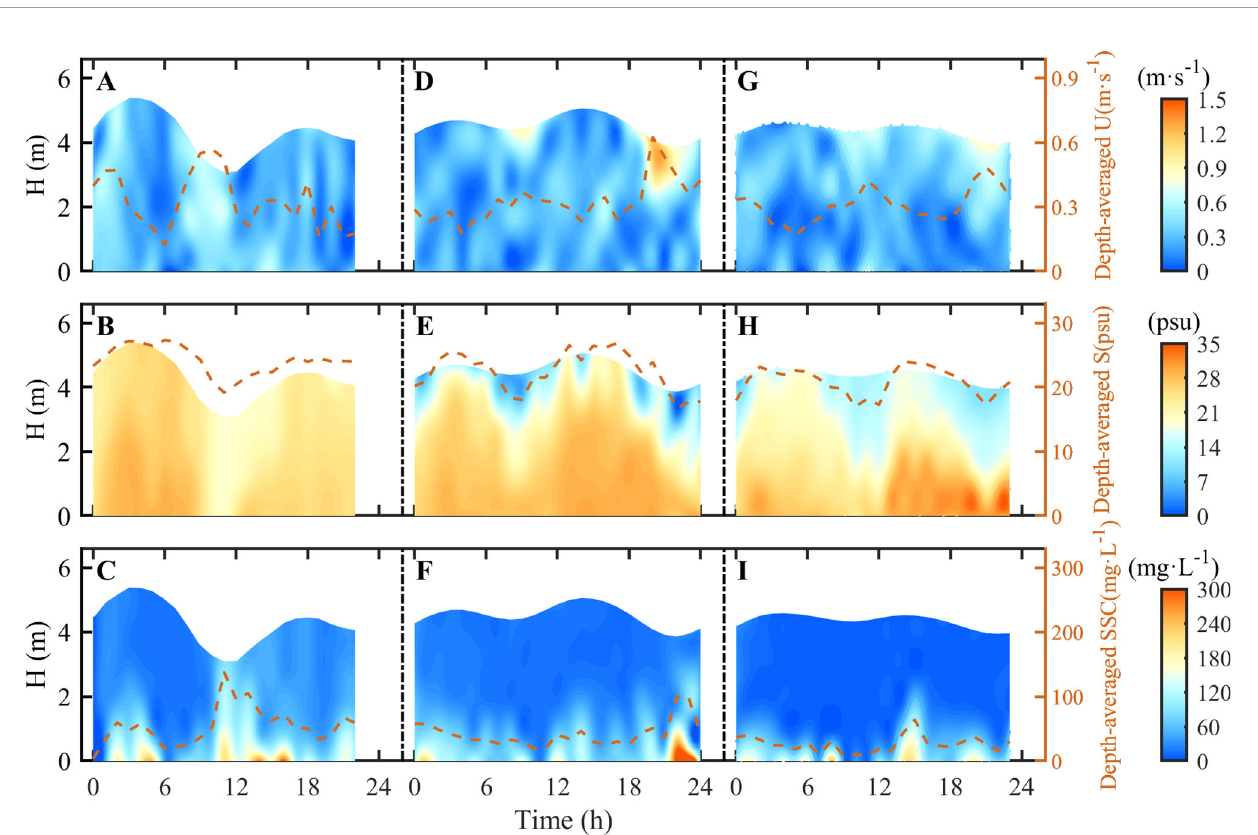
FIGURE 3 | Vertical and temporal variation of (A, D, G) current speed ( U , m·s -1 ), (B, E, H) salinity ( S , psu), and (C, F, I) suspended sediment concentration ( SSC , mg·L -1 ) at site M ( A – C, D – F, G – I , represent the spring, middle, and neap tides, respectively). The orange dashed lines are temporal variations of depth-averaged U , S , and SSC